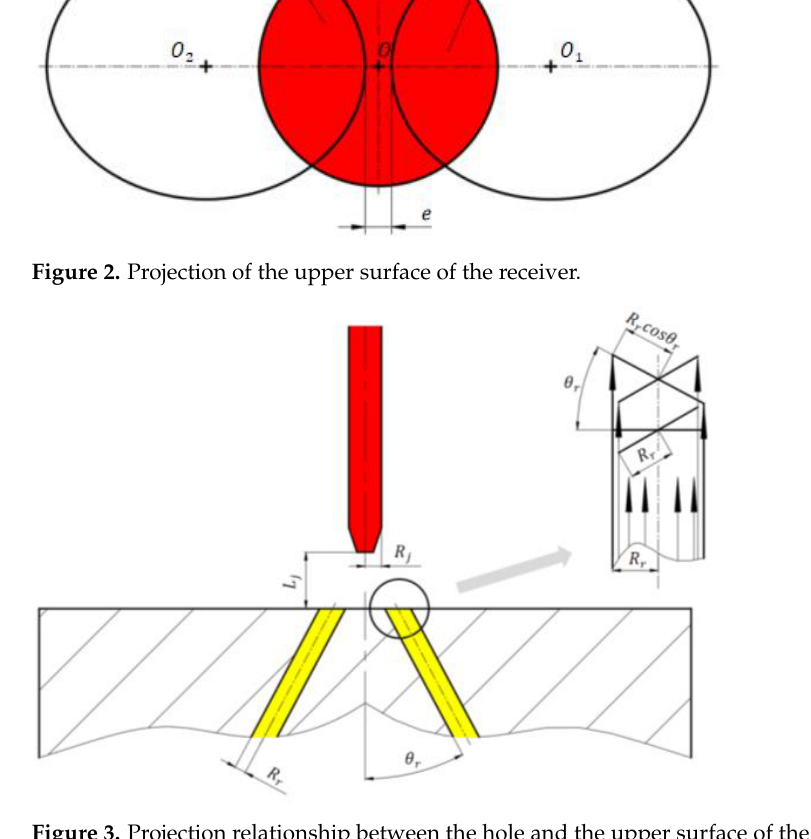
Figure 2. Projection of the upper surface of the receiver.